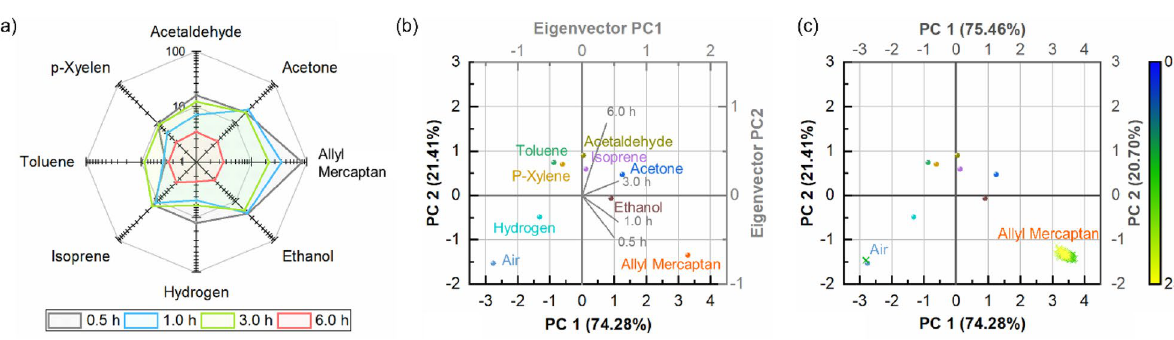
Figure 5. ( a ) Sensor signal response to various gases. ( b ) Scores plot of principal component analysis for various gases (Eigenvector values are Table S3). ( c ) Coordinates plot of air and allyl mercaptan gas on principal component analysis